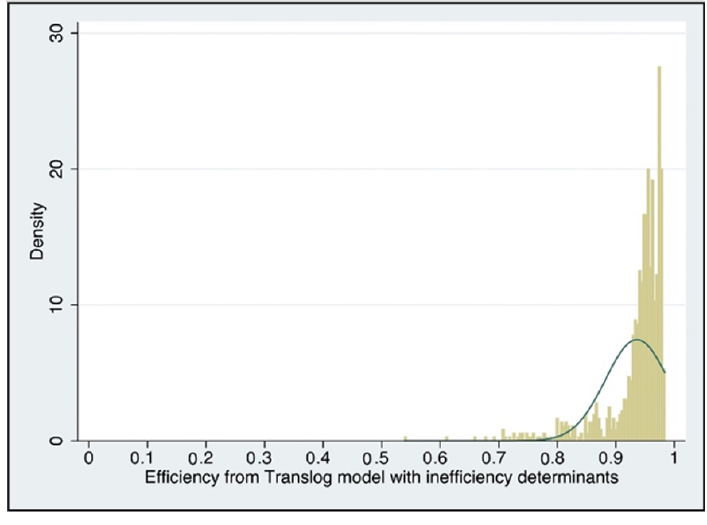
Figure 2. Histogram of efficiency scores.